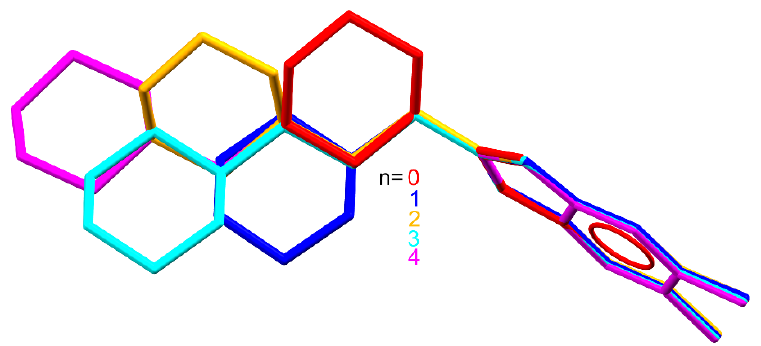
Figure 4. Spatial arrangement of benzimidazoles with a length of linker n = 0 –4.